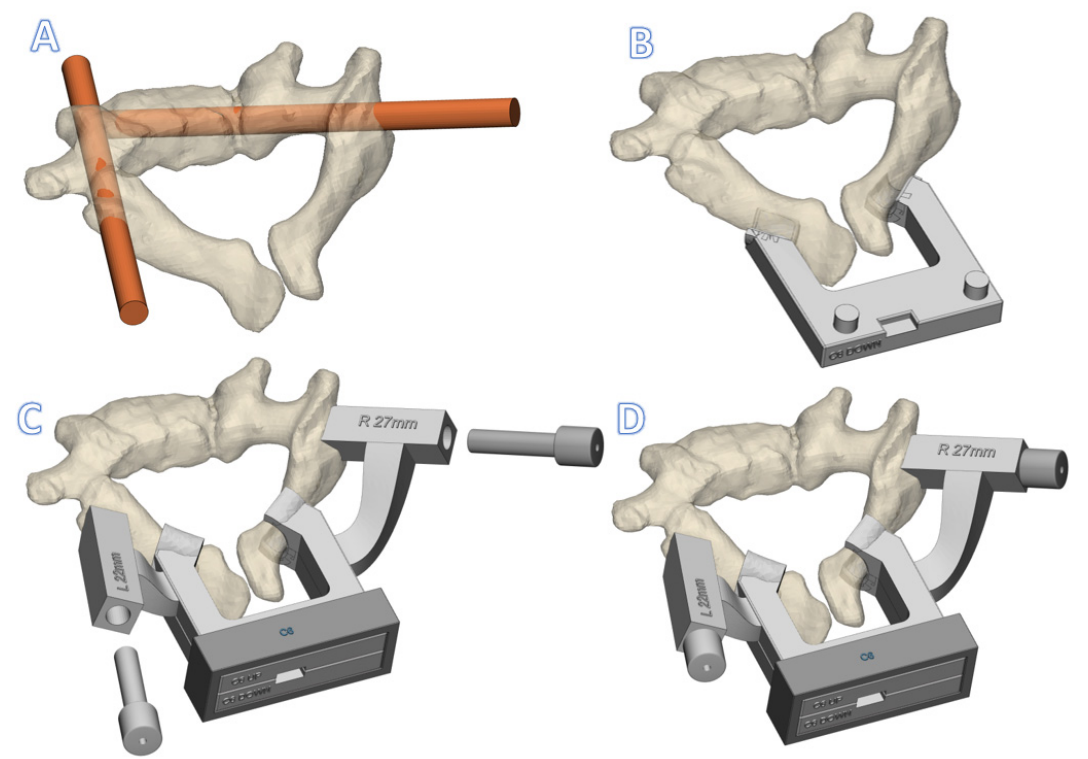
Figure 3. Rendering of a C6 click-on spine guide ( A ). The preferred screw trajectories ( B ). The interconnected lamina hooks of the caudal part ( C ). The cranial part including the drill guide cavities and the (metallic) drill guides ( D ). Fixation of the assembly with the fixation box, included the inserted drill guides.